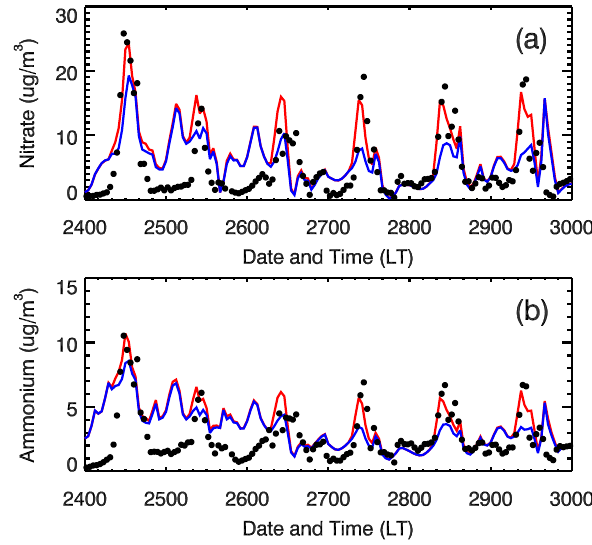
Fig. 11. Same as Fig. 8, except for (a) HNO 3 and (b) NH 3 .